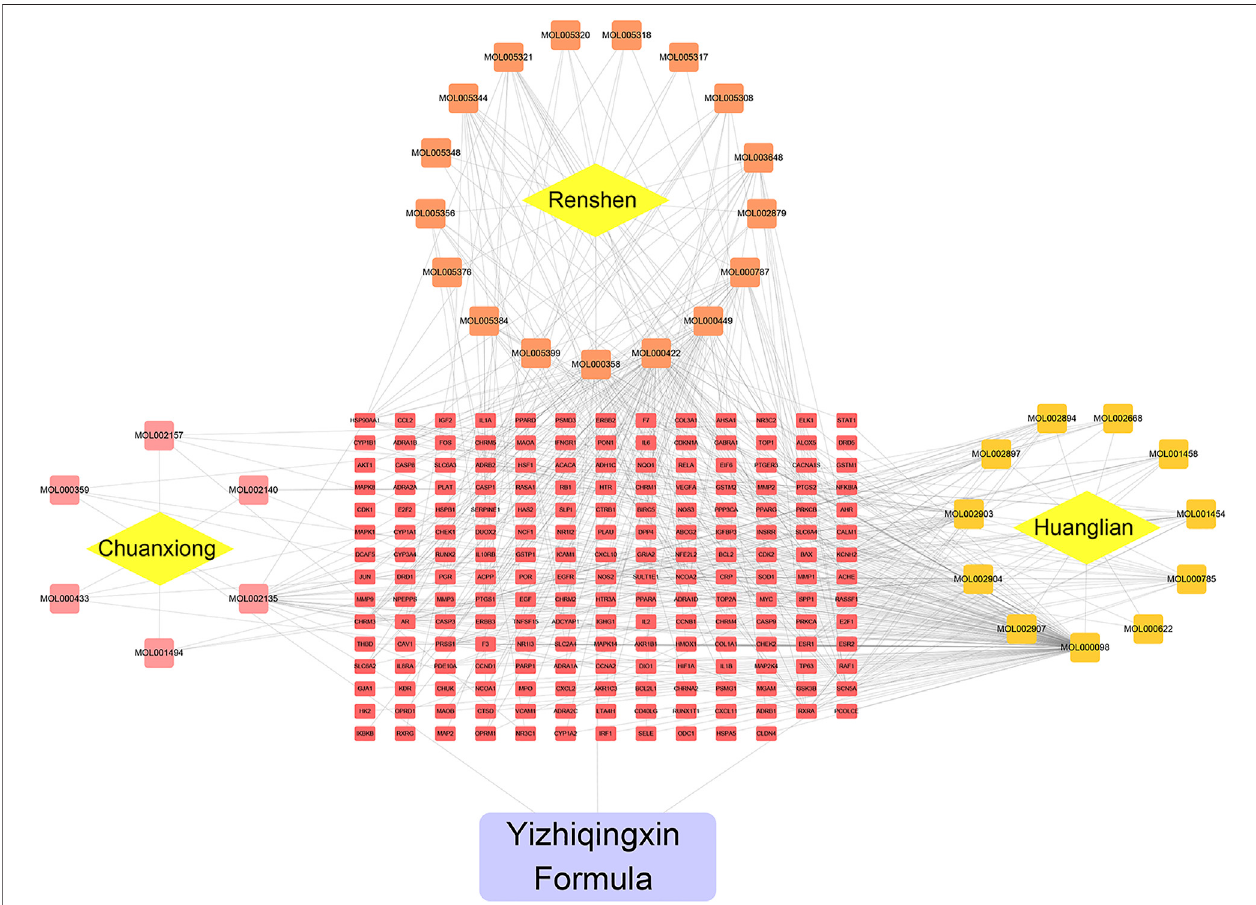
FIGURE2| Herb-Ingredient-targetnetworkofYZQX.Yellowrhombusrepresentsherb,thesquarerepresentsingredients,theredrectanglerepresentstargets,the purple rectangle represents the YZQX formula.